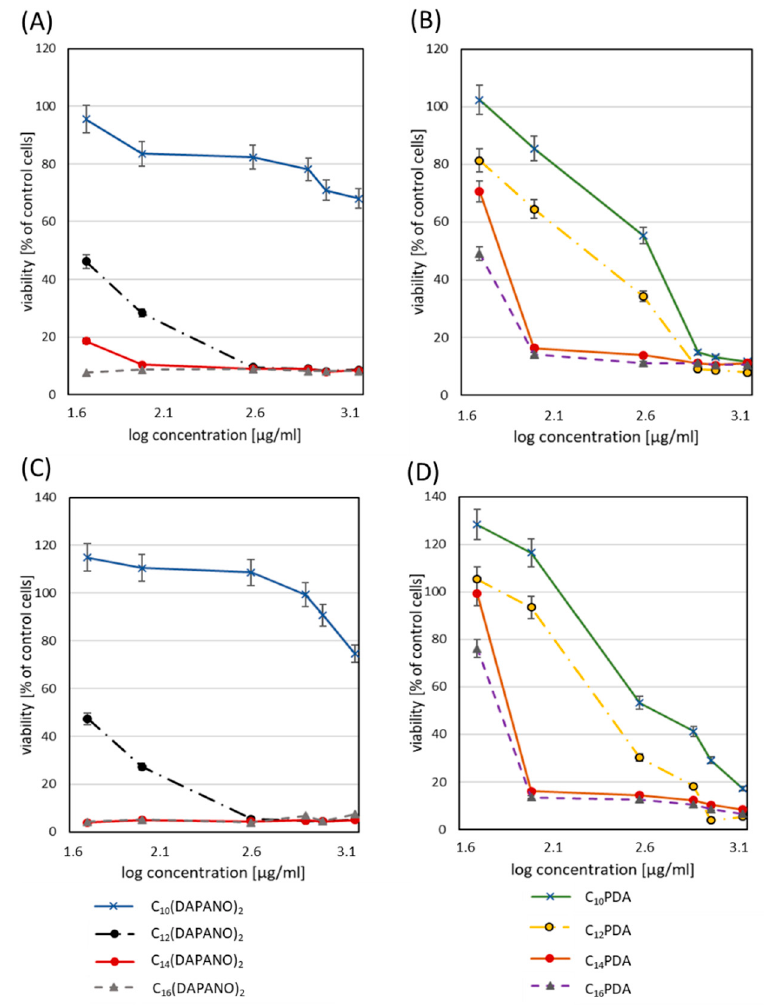
Figure 9. Evaluation of human keratinocytes viability after 24 ( A , B ) and 48 h incubation ( C , D ) with C n (DAPANO) 2 and C n PDA surfactants in the range 50–2000 µ